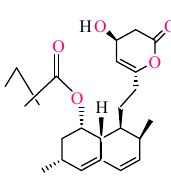
Figure 7: The chemical structure of simvastatin.